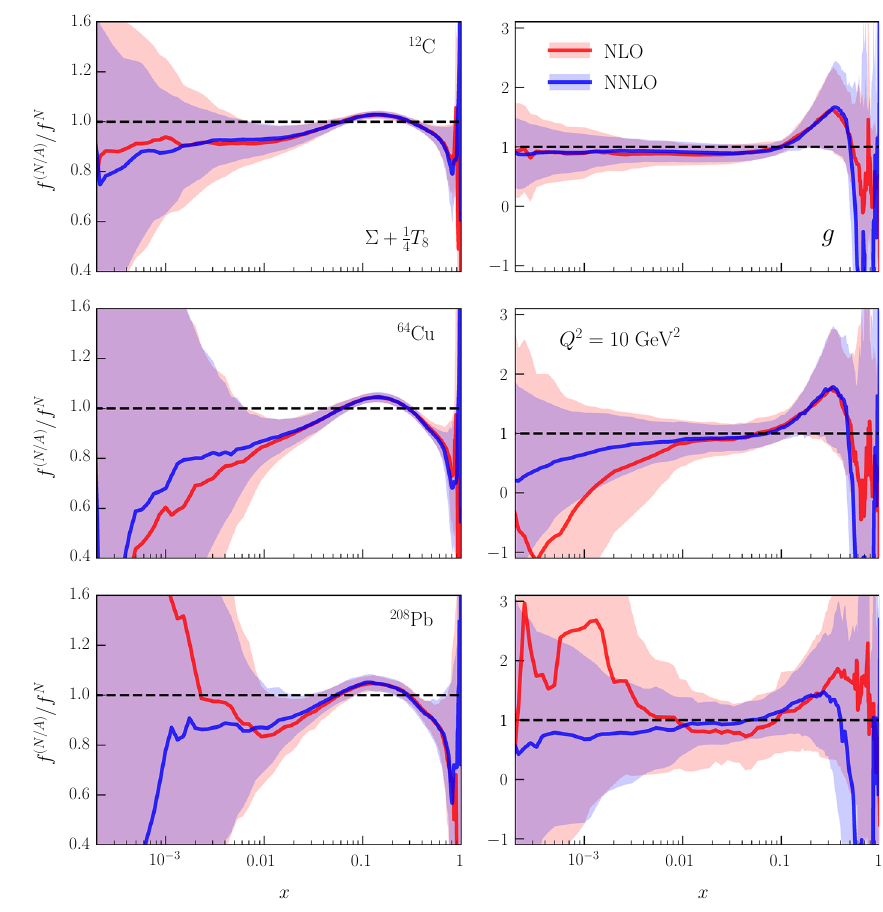
Fig. 20 Same as Fig. 17, but now comparing the results of the nNNPDF1.0 fits between NLO and